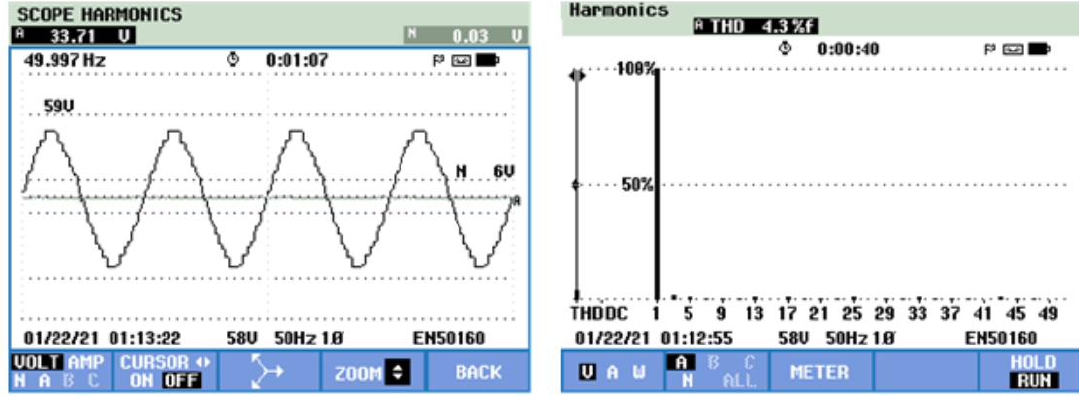
Figure 12. Harmonic spectrum.